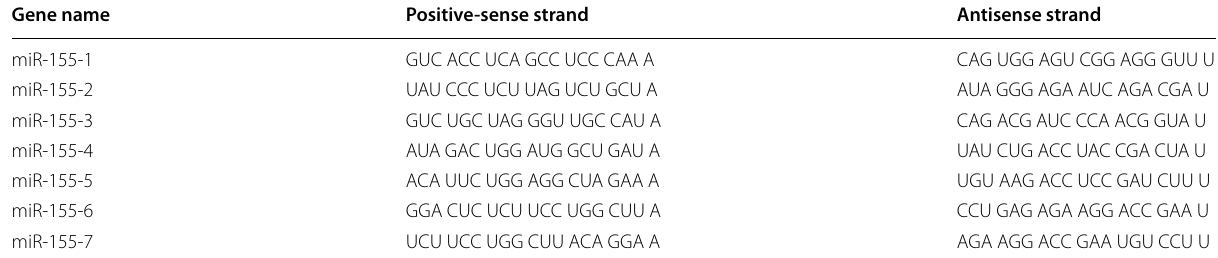
Table 1 Sequences in line with saRNA design